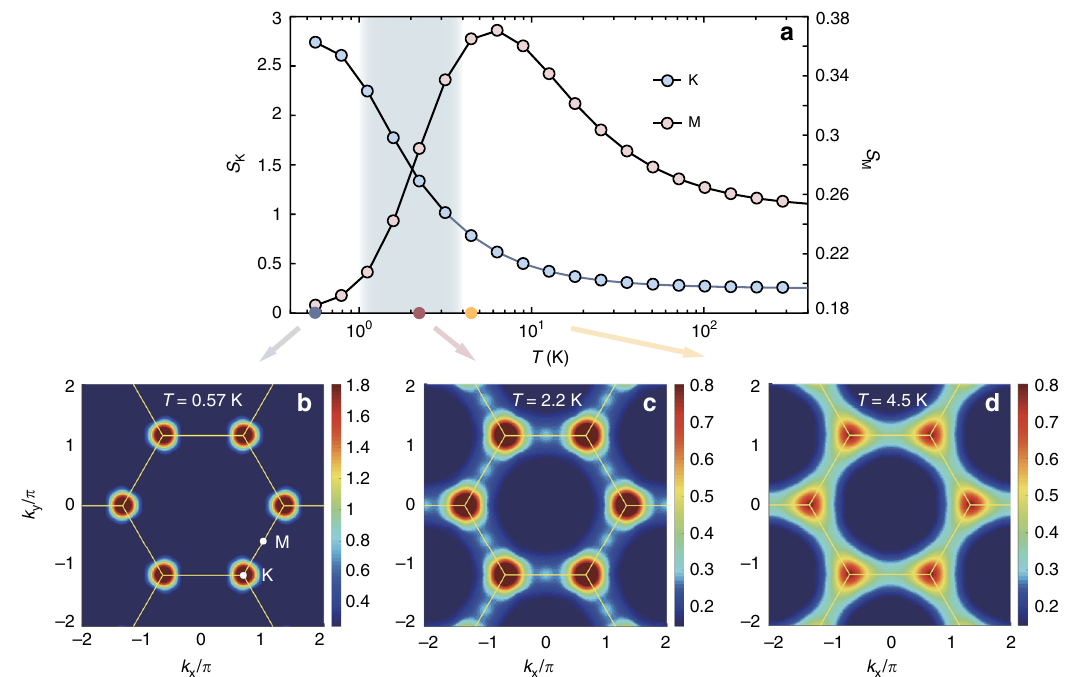
Fig. 5 Static magnetic structure factor of TMGO at fi nite temperatures. a The temperature dependence of the structure factor S (q) at M and K points indicated in b . The S M value enhances anomalously in the intermediate temperatures, whereas the K -point peaks become signi fi cantly strengthened, representing the full establishment of the three-sublattice clock order at T = 0.57 K as shown in b . c Shows the S (q) contour at T = 2.2 K, where a “ ghost ” peak appears at M, representing short-range stripy correlation. In d , as T further enhances to 4.5 K, the K peak clearly weakens and spreads out and the M ghost peak becomes virtually invisible.